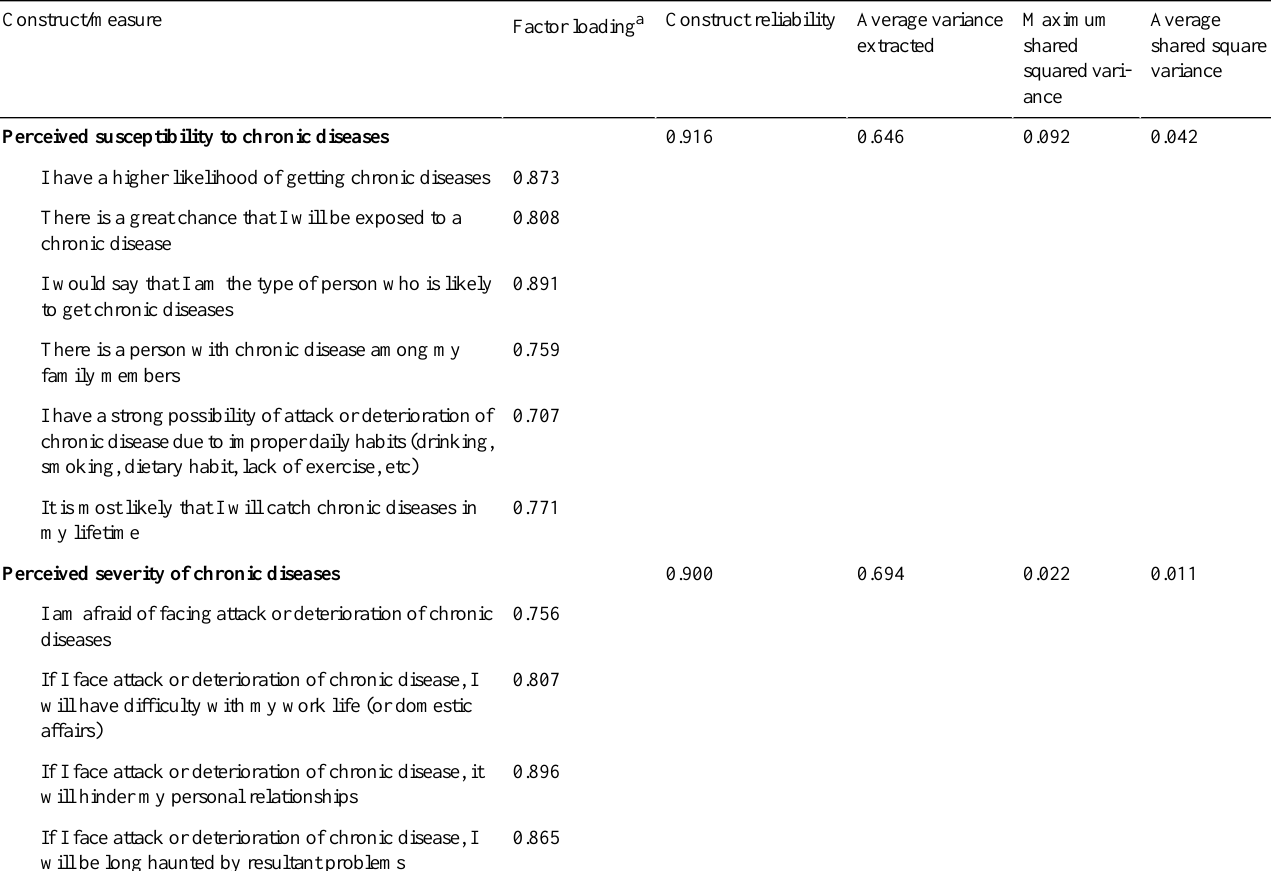
Table 3. Reflective constructs assessment.